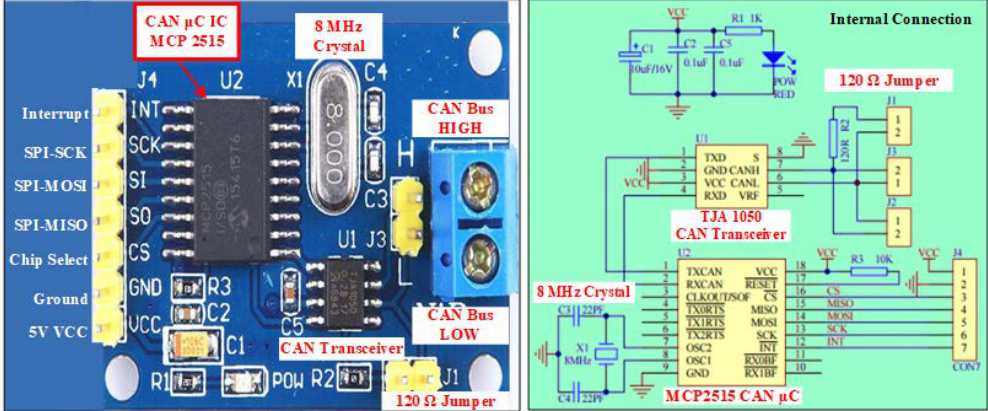
Figure 9. CAN Control shield schematics—MCP2515 module with their internal connection.